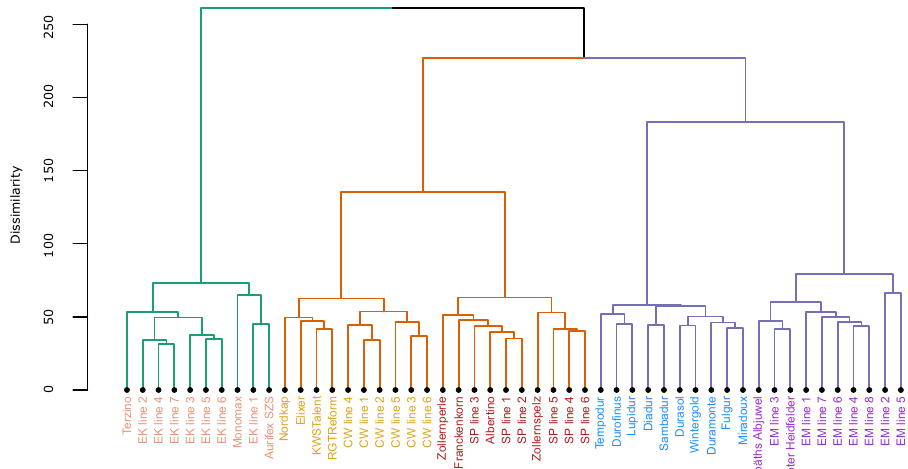
Fig. 2 Hierarchical clustering of 50 cultivars belonging to fi ve wheat species. The colors of the lines (branches) highlight three clusters of cultivars corresponding to their ploidy level. The colors of the cultivar labels correspond to the color legend for species in Fig. 1a. In total, 2774 proteins were used for clustering, which included proteins unique to one of the fi ve species and proteins common between species. All those proteins were identi fi ed across all three environments in at least one cultivar and hence belonged to the group J in Fig.